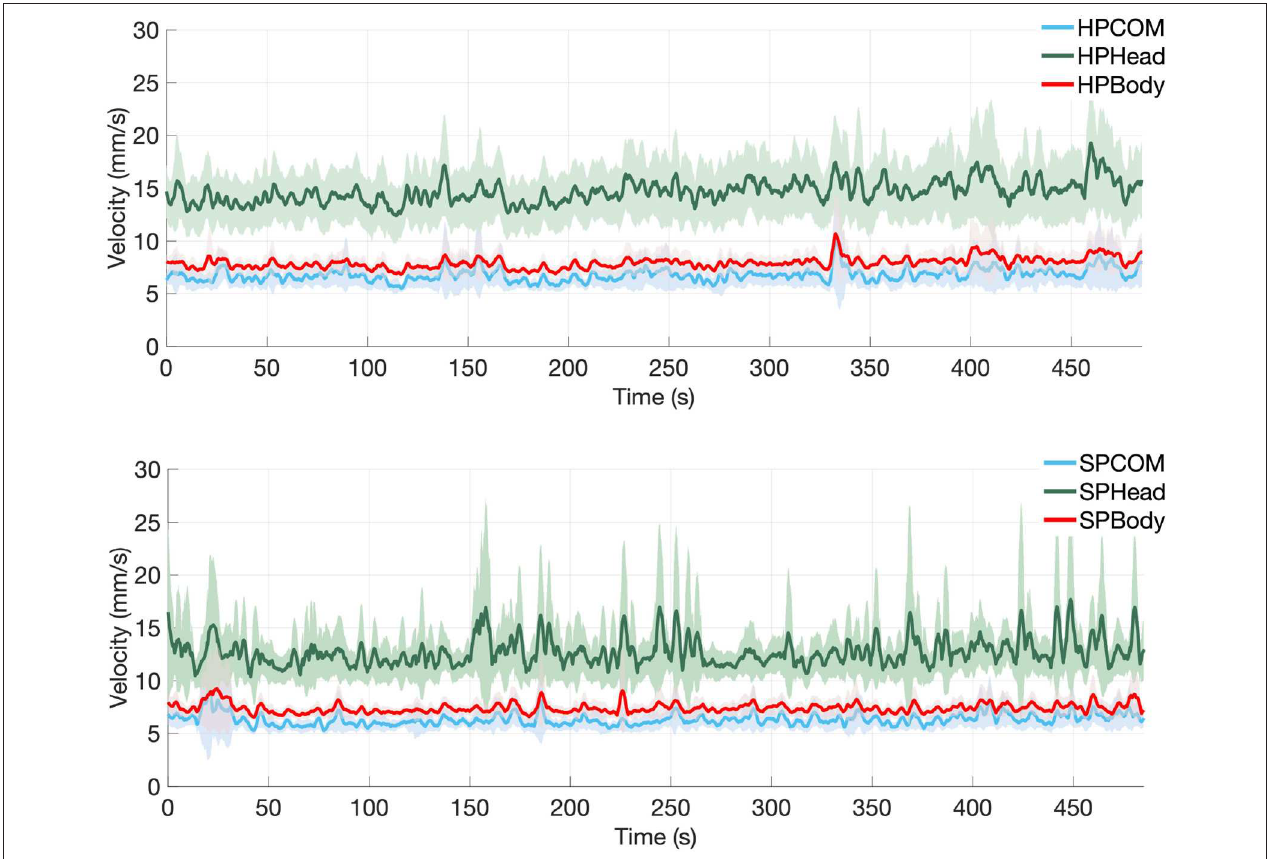
FIGURE 4 | Mean velocity values of Head Motion (Head), Center of Mass (CoM), and Whole Body Motion (Body) across all participants, with 95 % confidence intervals for the headphones condition (top) and for the speakers condition (bottom) for the whole trial (a total of 480 s, consisting of alternating segments of 30 s of silence and 45 s of sound stimuli, starting and ending with